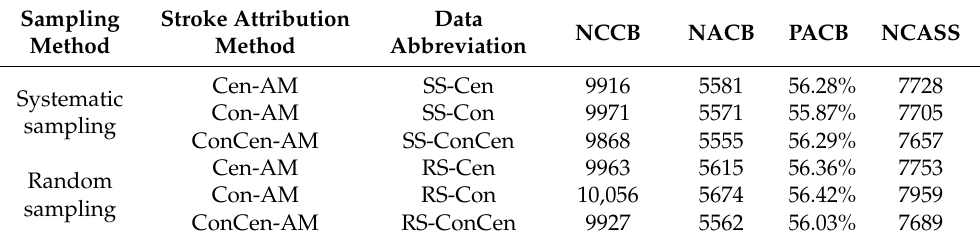
Table 3. Annotating the character block to be recognized.